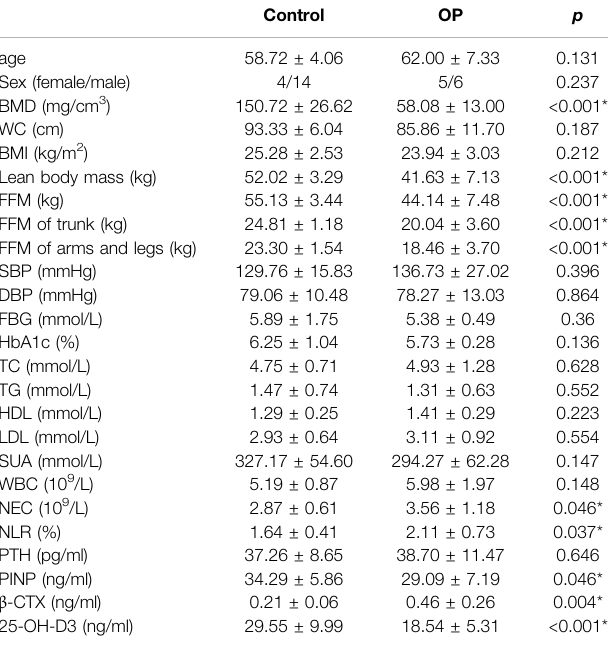
TABLE 1 | BMD, body composition, and clinical information of OP and control groups.